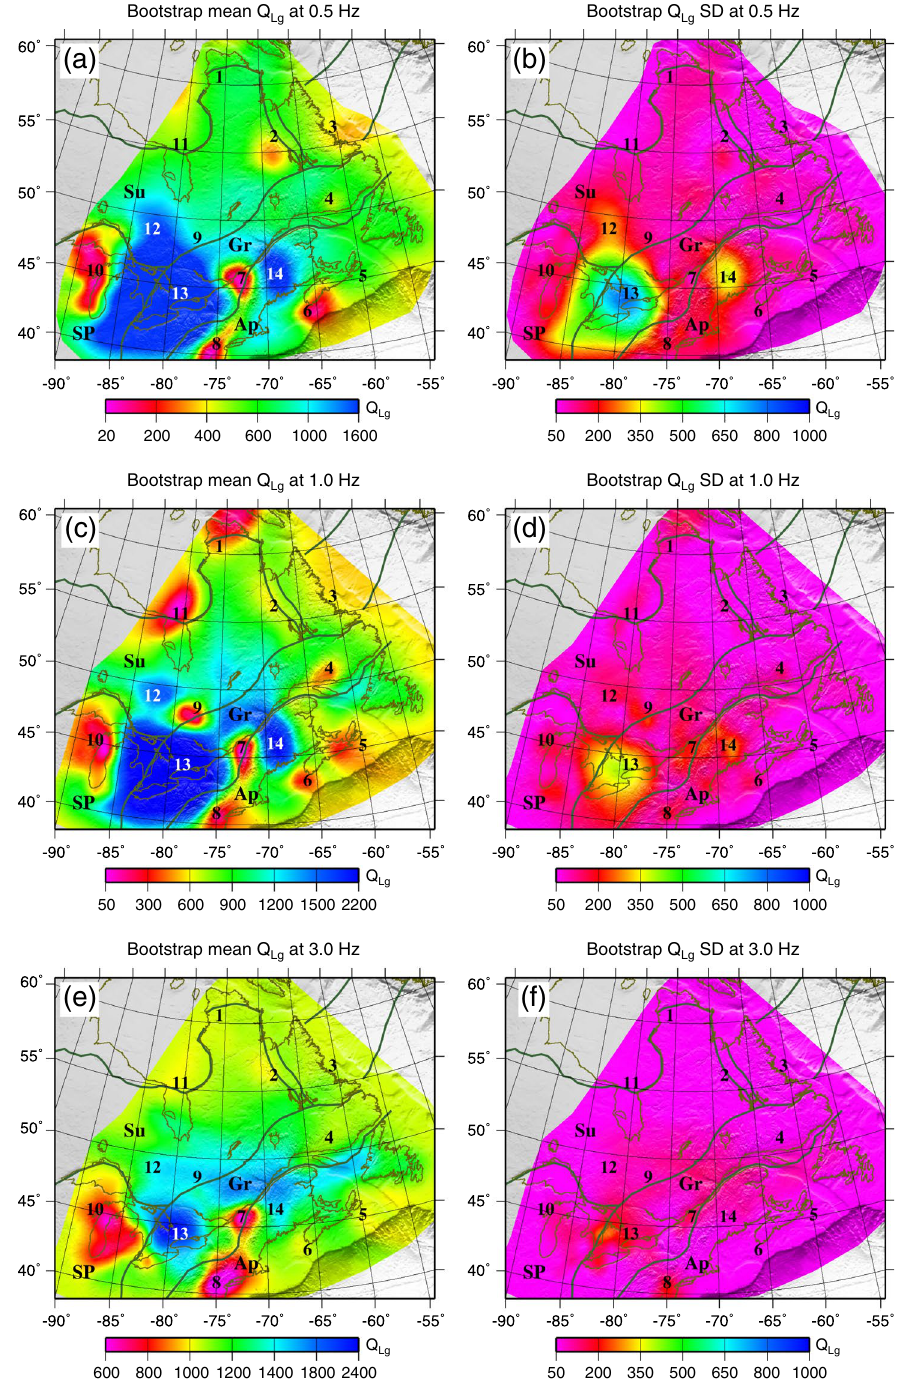
Figure 6. The mean Q distribution from Bootstrapping (left) and associated standard deviations (on the right). The figure is generated from GMT, which is an open source software available at: